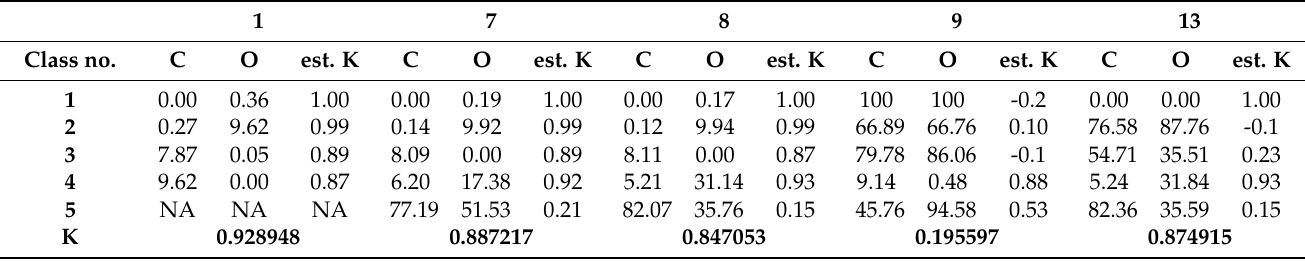
Table 6. The accuracy assessment for the Osijek study